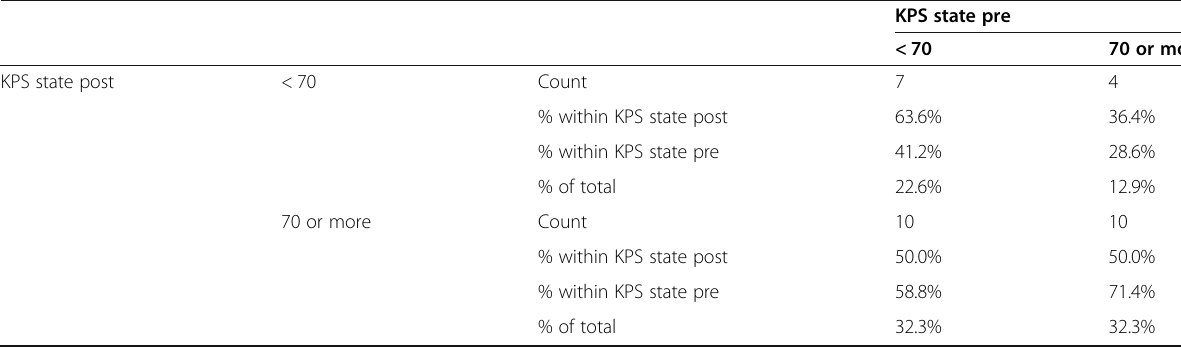
Table 4 The relationship between KPS state post and KPS state